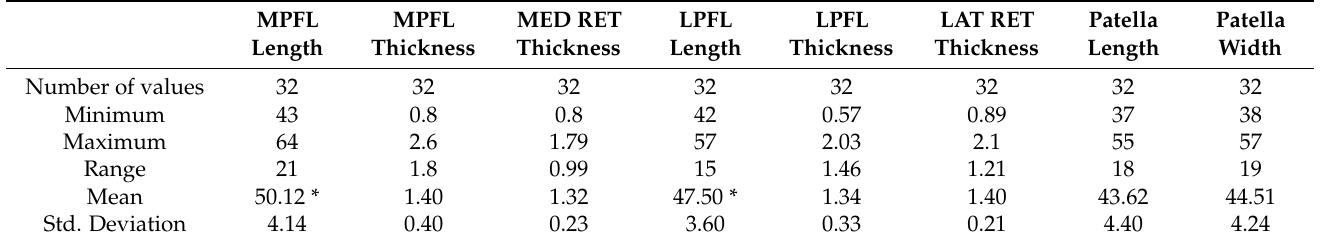
Table 4. Radiological measurements and statistical analysis of the radiological data.